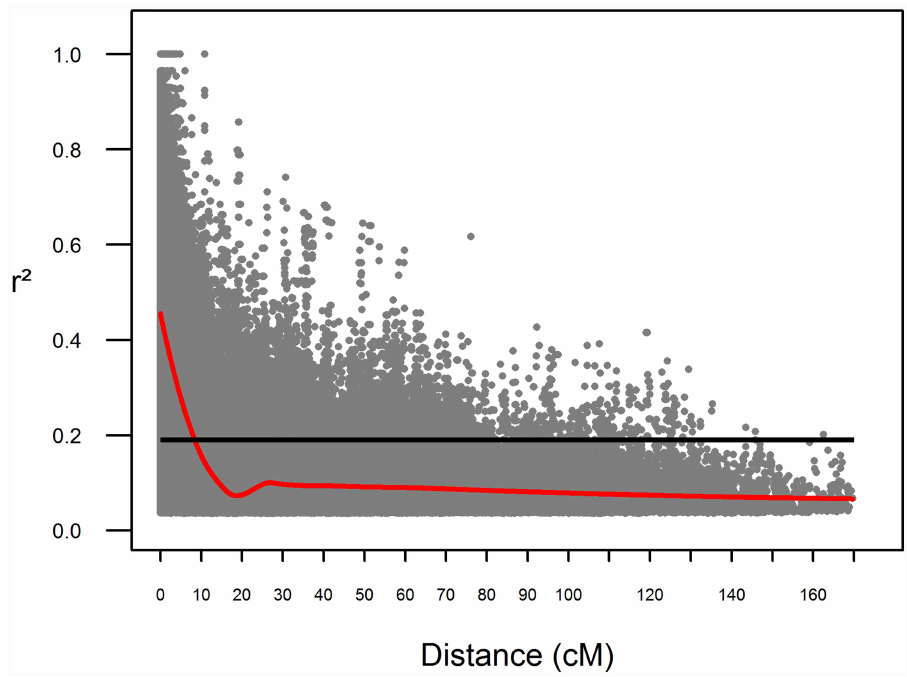
Fig 2. Average intra-chromosomal LD decay. r 2 values of LD are plotted as a function of the distance betweenpairs of markers considered. Black line: r 2 values of the 95 th percentile for unlinked( > 50cM) markers. Red line: second degreesmoothedloess